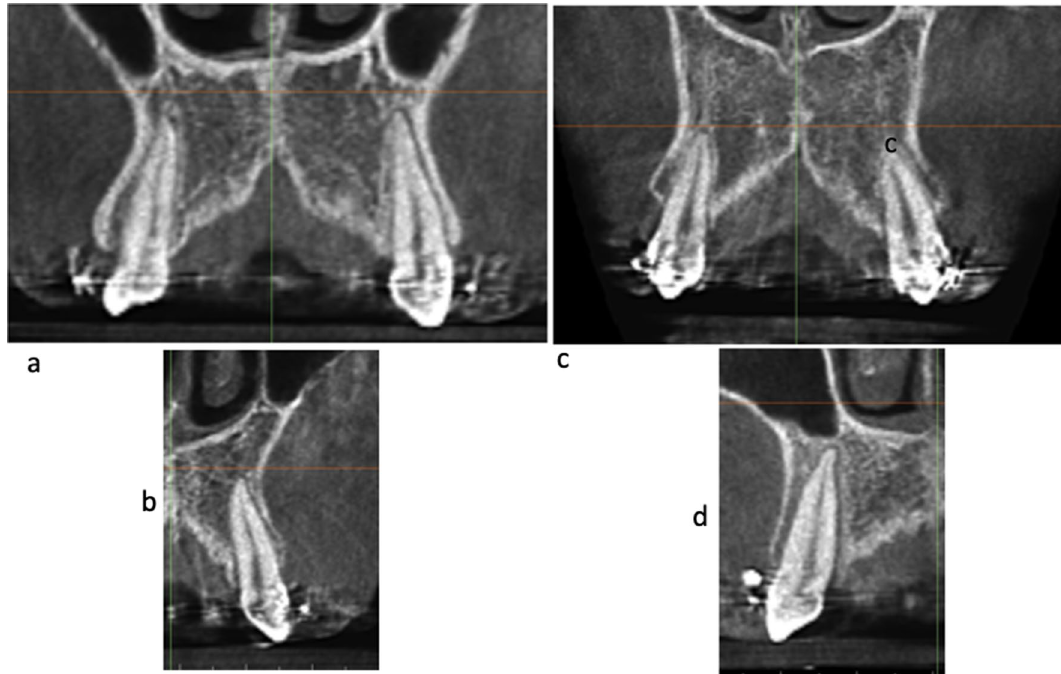
Figure 3. Examples of CRCR Grade A.